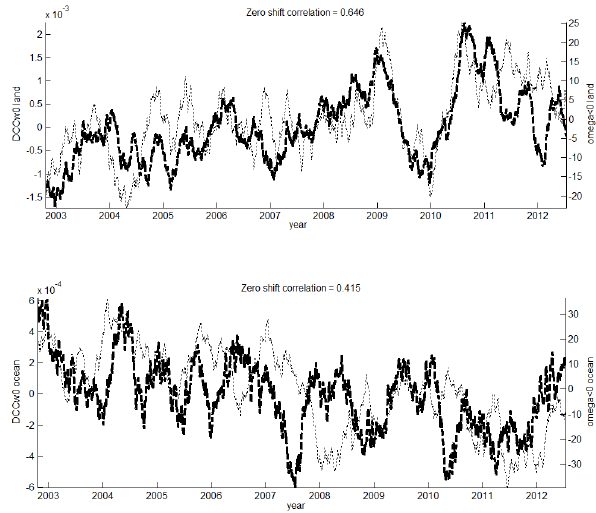
Figure 10. The land (top panel) and ocean (bottom panel) of the DCCw0 anomaly (heavy trace) 702 Fig. 10. The land (top panel) and ocean (bottom panel) of the compared with the ω 500 <0 anomaly, smoothed with a 96-day running average. 703 DCCw0 anomaly compared with the ω 500 <0